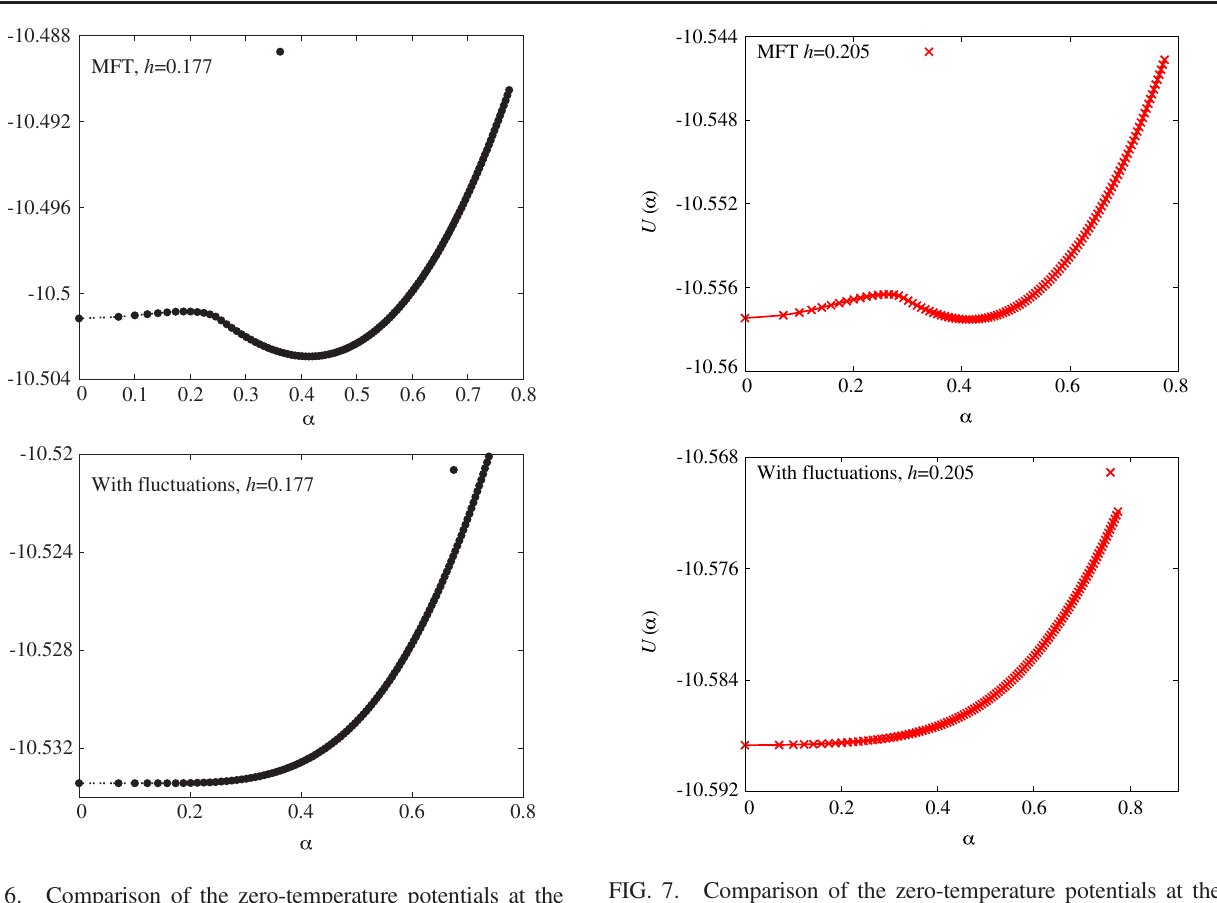
FIG. 6. Comparison of the zero-temperature potentials at the new QCP (black circles at h ¼ 0 . 177 , T ¼ 0 in Fig. 3). Mean- field theory (top) incorrectly predicts a phase-separated fully gapped BCS plus excess fermion state with the global minimum at α 0 ¼ 0 . 42 , which overshadows the Fermi surface mismatch. Fluctuations (bottom) smear out the curved region in the potential and, in fact, lead to a quantum phase transition with continuously onsetting superfluid order α 0 slightly above zero. Numerical parameters and initial values of the Z and X factors are g ¼ − 2 , Z Λ 0 Ω ¼ Z Λ 0 q ¼ 1 , and X Λ 0 ¼ 0 . 2 . Further technical details are given in Appendix B.